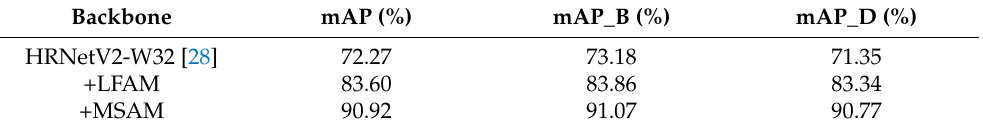
Table 5. Effects of LFAM and MSAM on LrNet under CrdNet. LrNet is improved by adding